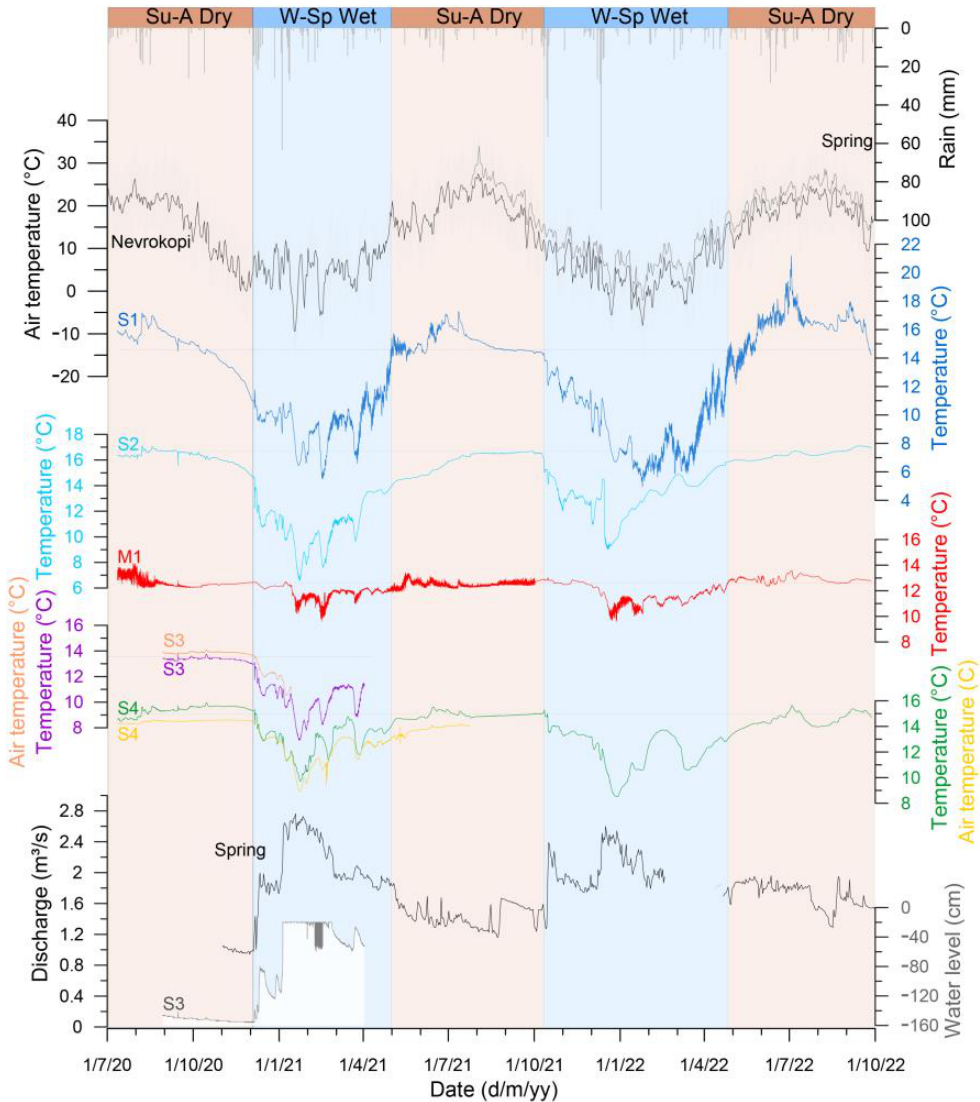
Figure 3. Graphs with the complete records of water temperature, water level, and air temperature inside the cave, precipitation and air temperature at Nevrokopi polje close to the ponor, and air temperature and discharge at the spring. Air temperatures outside are shown as daily mean in addition to daily maximum and minimum temperatures for the Nevrokopi record. Discharge data are shown as daily mean values though the values are not reliable; however, abrupt rises indicate rapid increases in flow rate. The flat top of the water level curve is an artefact because the level was out of the range of the sensor. Blue colour bars represent the winter–spring wet season (W-Sp Wet), while brown bars represent the summer–autumn dry season (Su-A Dry). The dotted horizontal lines mark the stable temperature (defined by September